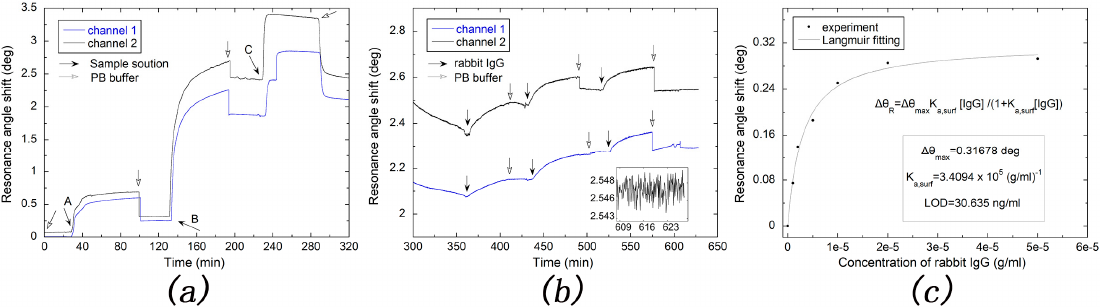
Figure 8. ( a ) Real-time monitoring the modification of the gold-based SPR sensor with A is 10 mg/mL EDC solution, B is 50 ug/mL GAR IgG and C is 3% BSA solution; ( b ) The resonance angle shift for detecting different concentrations of rabbit IgG (1, 5, 20 ug/mL for channel 1 and 2, 10, 50 ug/mL for channel 2) and the inset shows resonance angle shift curve after detecting rabbit IgG; ( c ) Langmuir fitting with data measured from ( b